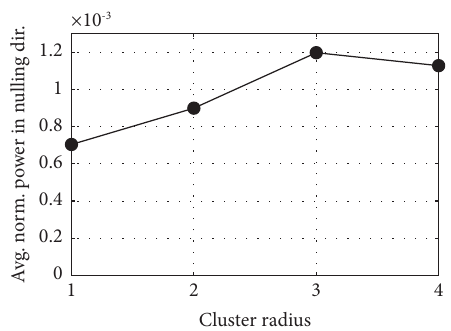
Figure 20: Average normalized power in the nulling directions against cluster radius. Te radius values are wavelength- Table 19: Null width (in degrees) corresponding to null steering at radii 1, 2, 3, and 4 (wavelength normalized). Te null width has been measured at the − 20dB power level in the average array factor.